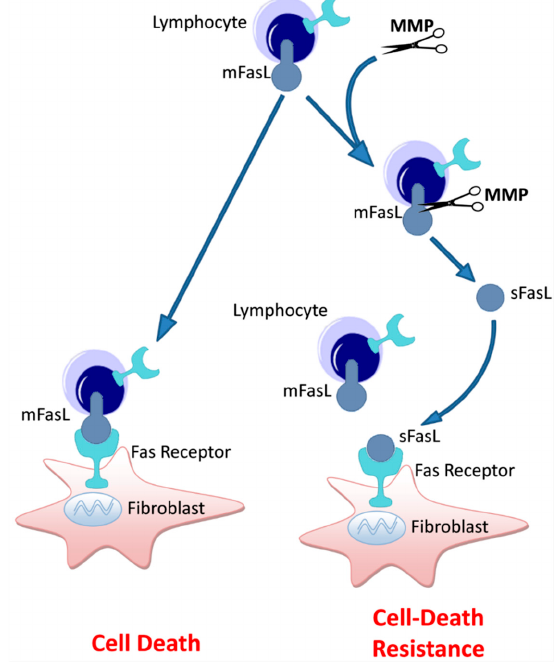
Figure 5. Simplified scheme of the proposed model of sFasL, MMP-mediated, immune cell-induced myofibroblast death regulation during lung fibrosis. Lymphocytes are known to express mFasL that enables T cell-induced myofibroblast cell death with resolution of fibrosis. In fibrotic-lung myofibroblasts, in the presence of MMPs, high levels of sFasL are detected due to mFasL cleavage. High sFasL in the milieu competes with mFasL and limits T cell-induced cell death. sFasL secreted by fibrotic lung fibroblasts is an additional mechanism of their resistance to cell death and their uninterrupted accumulation in lung